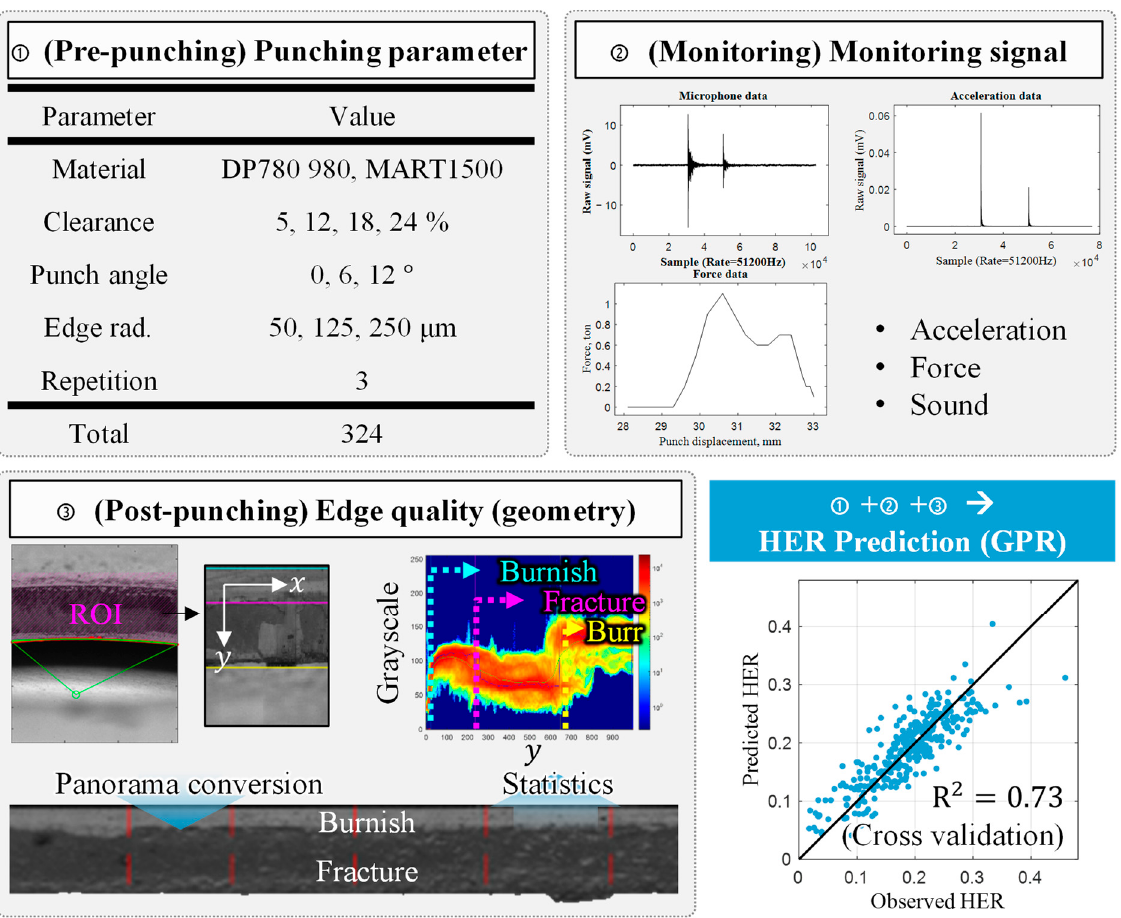
Figure 2. Overall procedure for predicting the HER value.